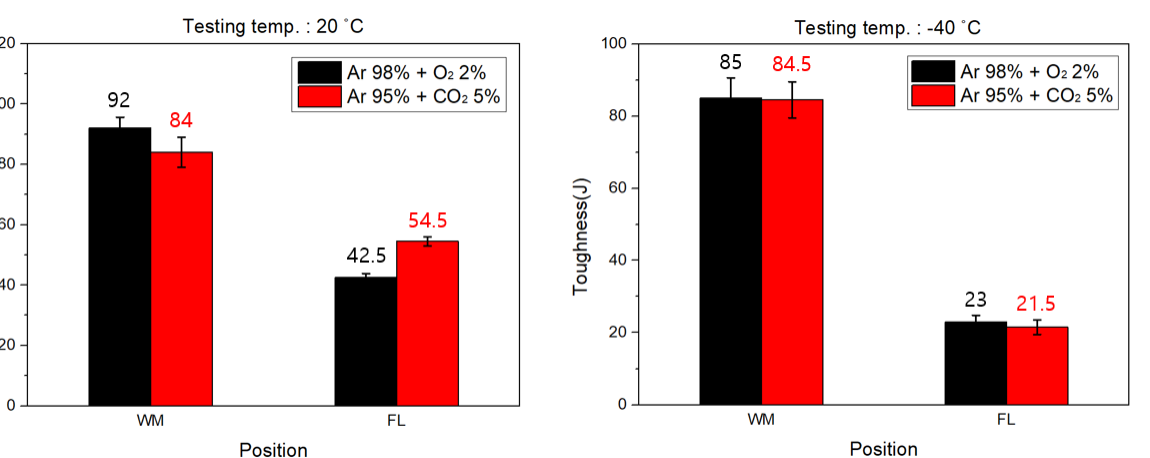
Figure 3. Hardness test results with variation of shielding gas.